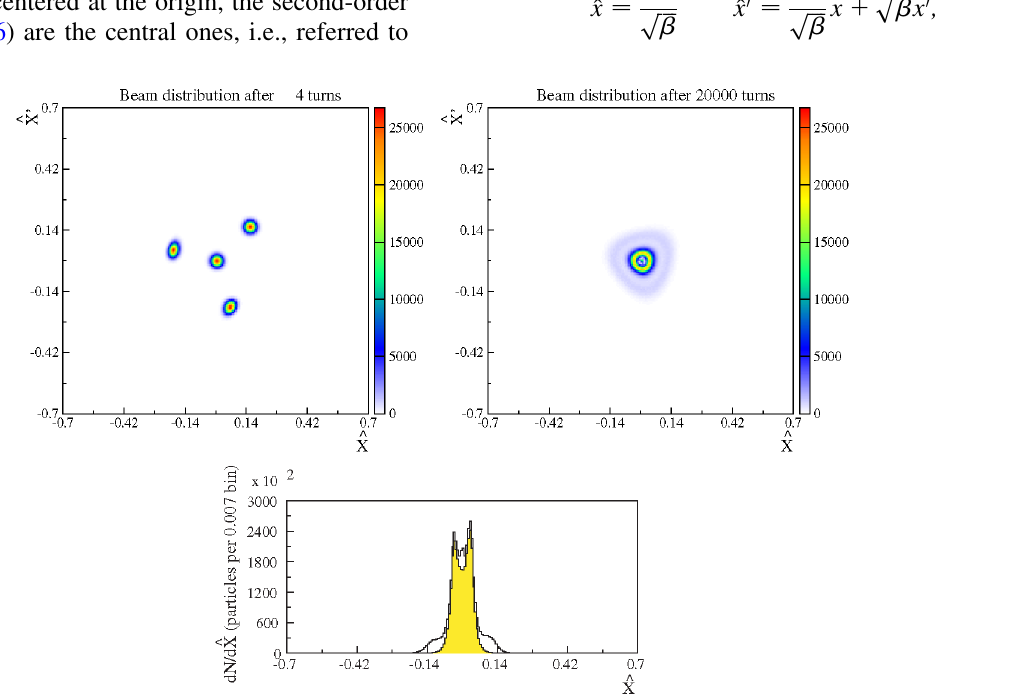
FIG. 6. (Color) Final distribution function for a variant of the three-turn injection with a fourth injected turn. The distribution at the end of the injection process is shown in the upper left part, while the final distribution is shown on the upper right part. The projection of the final beam distribution is plotted in the lower part. The extended halo is visible in both the final 2D beam distribution as well as its projection along the ^ X